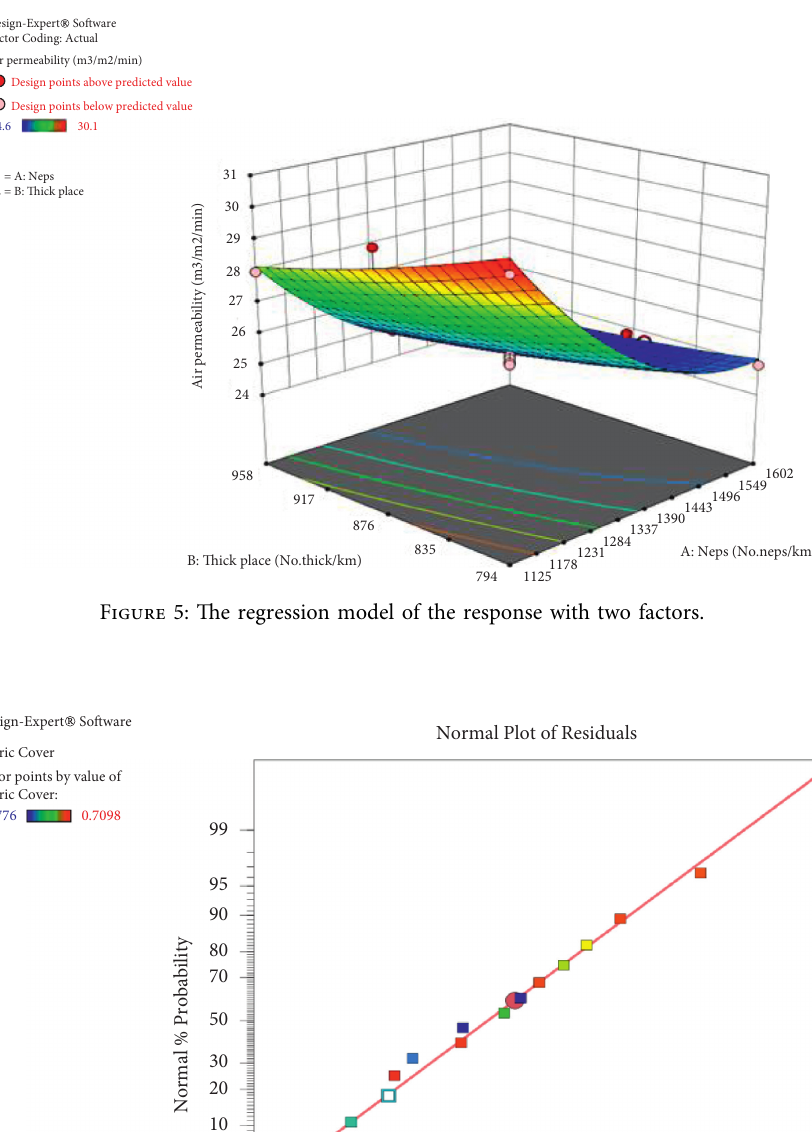
Figure 6: The normal plot of